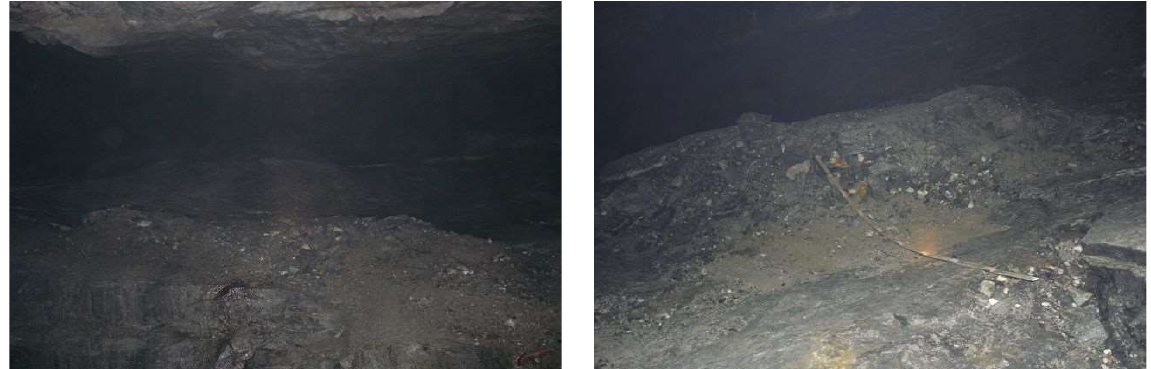
Figure 5. View of stope footwalls with accumulated residues. Stope height approx. 1.5 m.